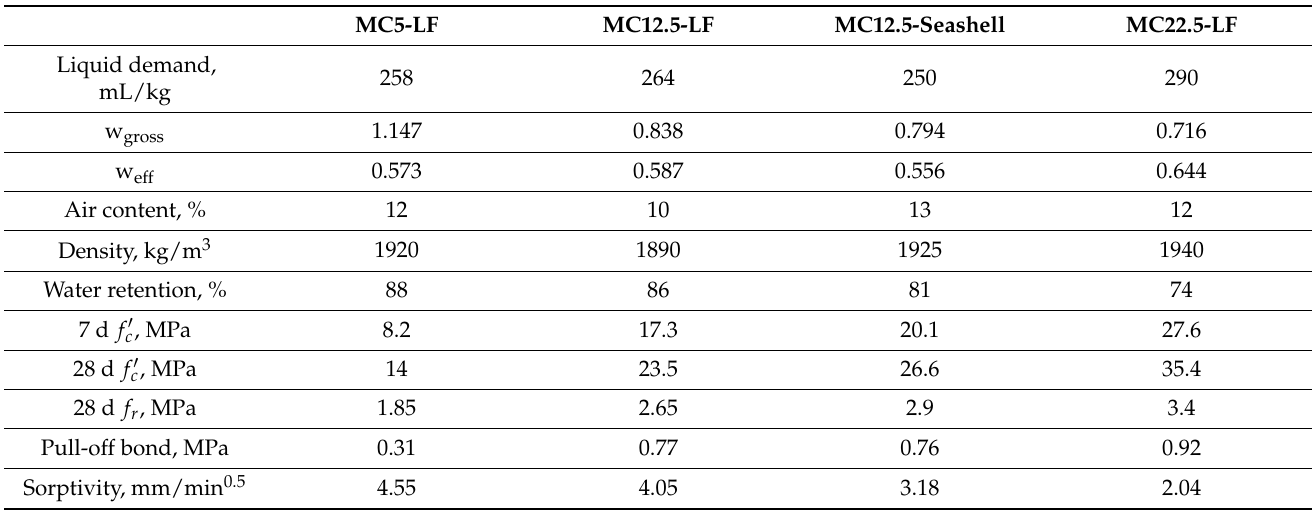
Table 3. Physical and mechanical properties for mortars containing MC